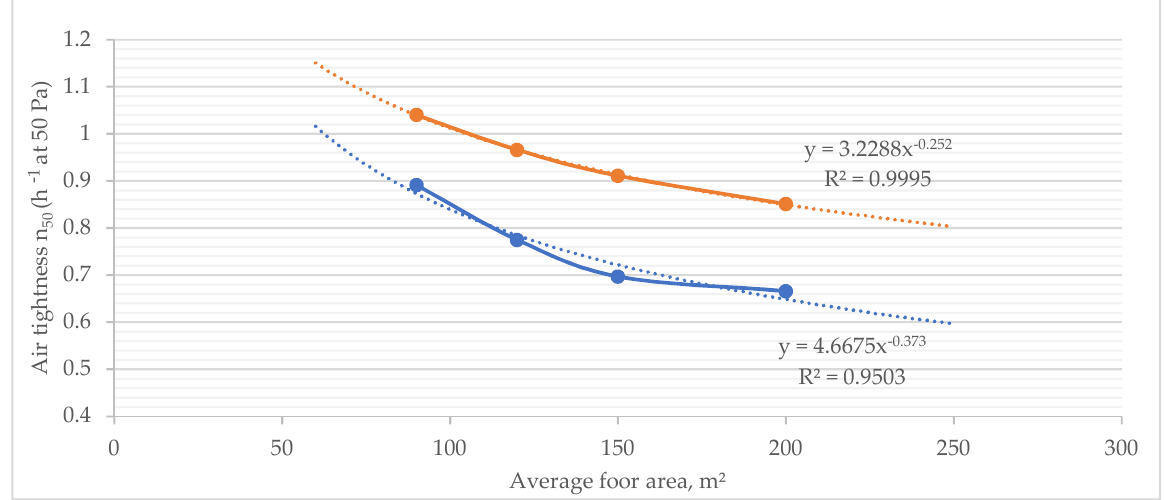
Figure 5. Dependency diagrams of airtightness and floor area for the end (orange) and inside (blue) units in the sand–lime buildings of energy efficiency class A.